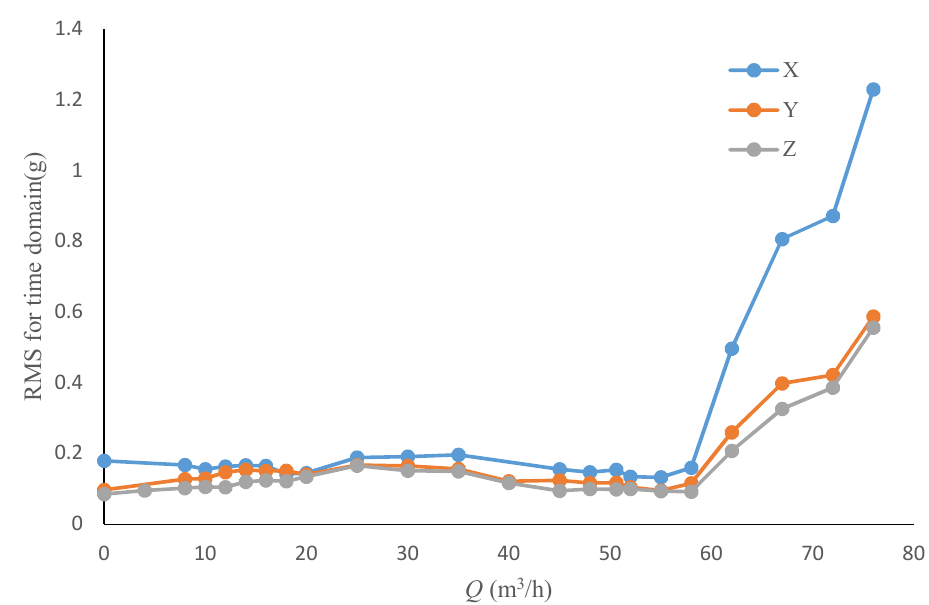
Sensors 2020 , 20 , x FOR PEER REVIEW Figure 18. RMS for the di ff erent direction time domain vibration signal under di ff erent flowrates. Figure 18. RMS for the different direction time domain vibration signal under different flowrates.